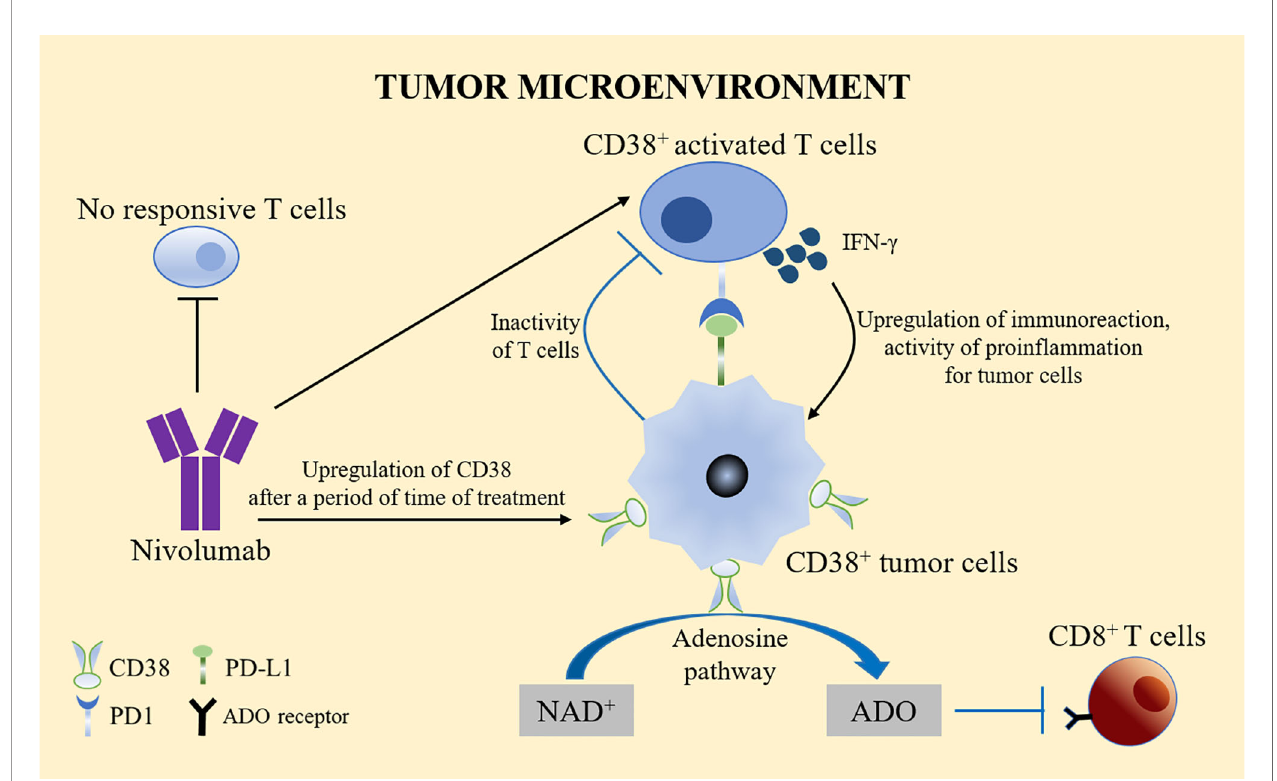
FIGURE 3 | CD38 treatment and PD-1/PD-L1. Nivolumab signi fi cantly reduced the number of non-reactive T cells and increased the number of activated T cells expressing CD38. Activated CD38 + TILs produced cytotoxic compounds and in fl ammatory cytokines, such as IFN- g to upregulate the immune response and exert pro-in fl ammatory effects on immune in fi ltration and tumor cells. However, CD38 is usually upregulated after a period of anti-PD-1/PD-L1 treatment. The adenosine activity of CD38 in turn leads to the inhibition of CD8 + T cells, which might partly explain the high drug resistance rate observed in patients treated with PD-1/PD-L1 blockers. Pharmacological targeting of the adenosine pathway could reverse the immunosuppression caused by the upregulation of